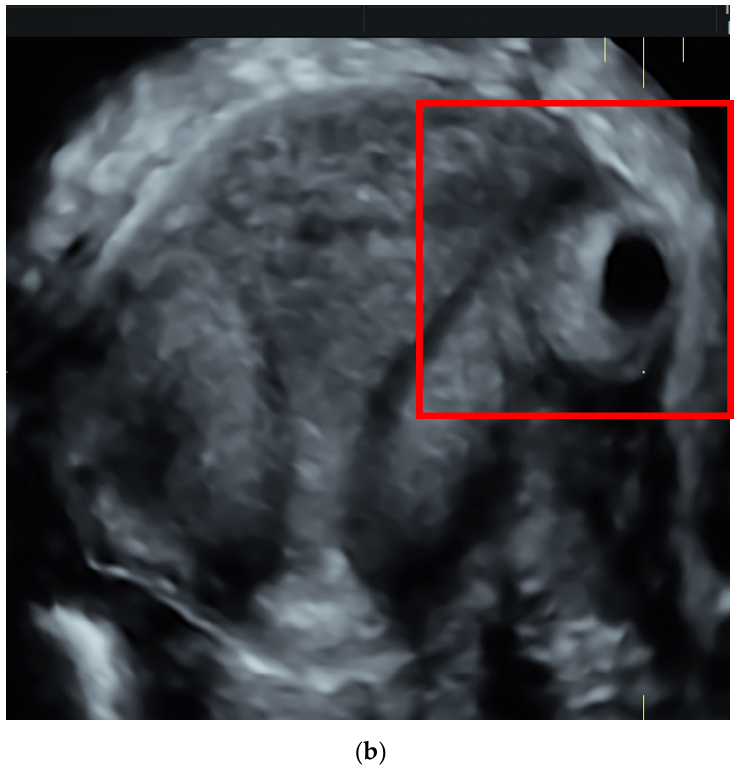
Figure 1. Ultrasound findings of interstitial pregnancy ( a ) A 3-D ultrasonography: an empty uterine cavity with a gestational sac located > 1 cm from the sideward portion of the uterine cavity; the continuation of myometrial mantle around the ectopic sac is clearly viable. ( b ) A 2D-view of the interstitial pregnancy surrounded by a myometrial layer of less than 5 mm. Table 1. Management of interstitial pregnancy using systemic MTX combined with Oral mifepristone.